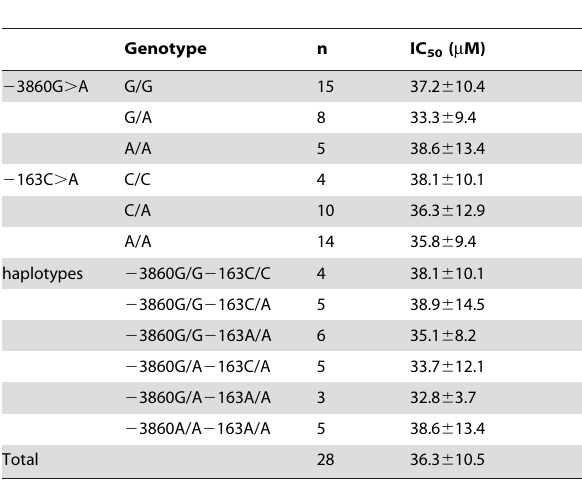
Table 3. Effects of SNP 2 3860G . A and 2 163C . A on IC 50 of baicalin for CYP1A2 in HLMs mean 6 SD.